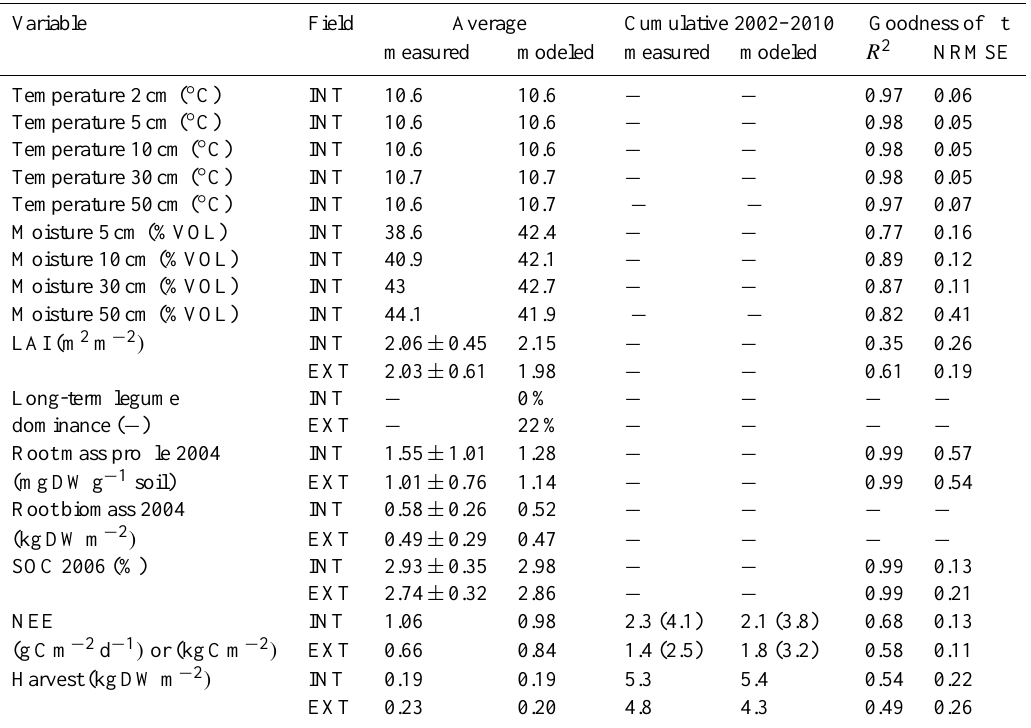
Table 5. Model performance on soil, biomass, and carbon budget parameters for 2002–2010. Note that only pairs of modeled and measured values are included in cumulative and average values to facilitate comparisons. Sums of measured NEE, gap-filled with annual averages, are shown in brackets. Criteria for goodness of fit are given when n >